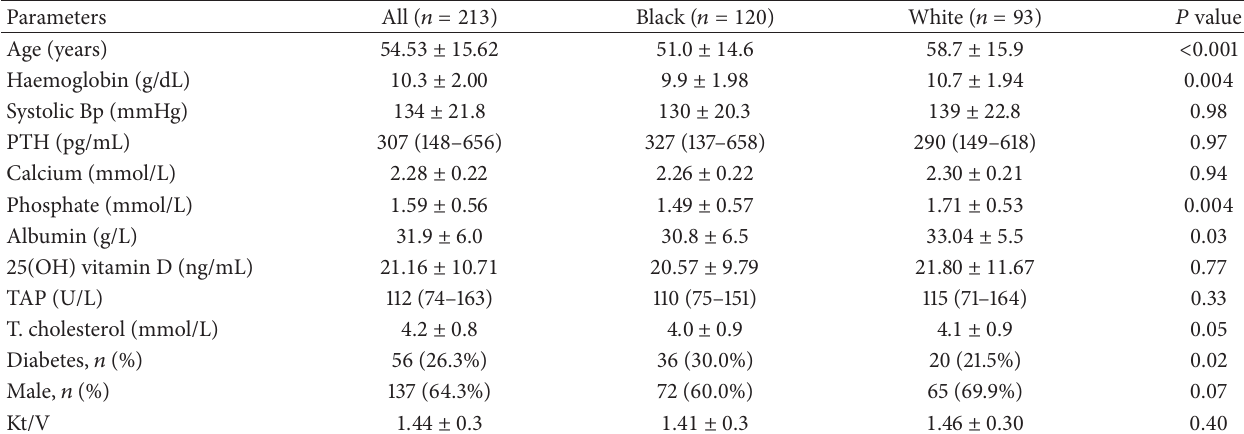
Table 2: Baseline characteristics of study population by race.